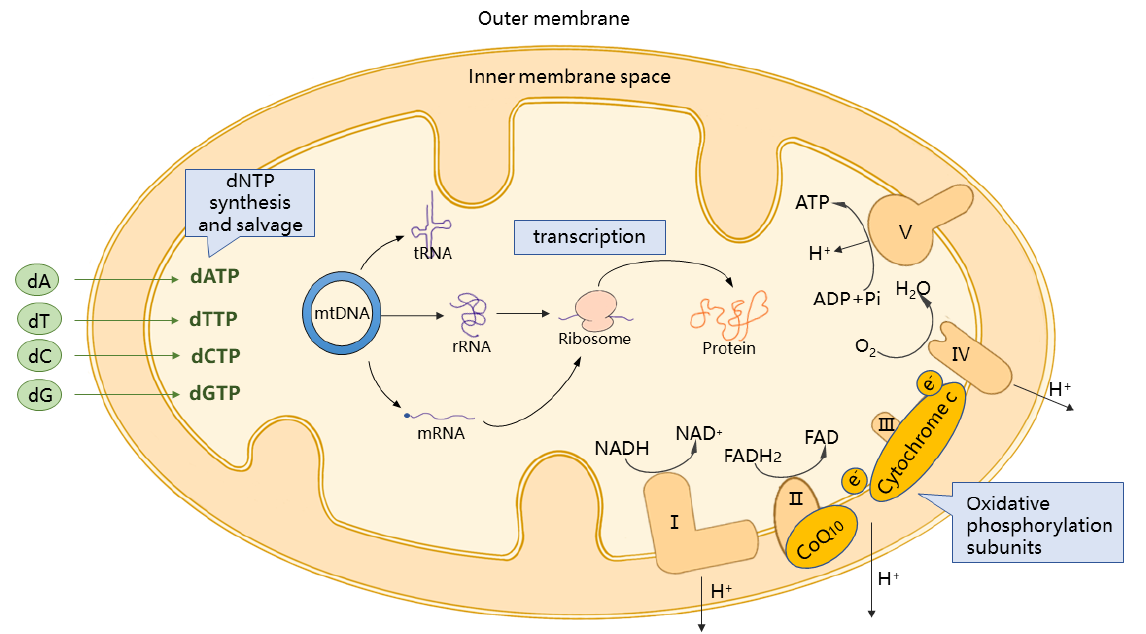
Figure 1. Illustration of mitochondrial oxidative phosphorylation system and other pathways. dA = deoxyadenosine. dC = deoxycytidine. dG = deoxyguanosine. dT = thymidine. dATP = deoxyadeno- sine triphosphate. dCTP = deoxycytidine triphosphate. dGTP = deoxyguanosine triphosphate. dNTP = deoxynucleoside triphosphate. dTTP = deoxythymidine triphosphate. mtDNA = mitochon- drial DNA. Pi = phosphate.